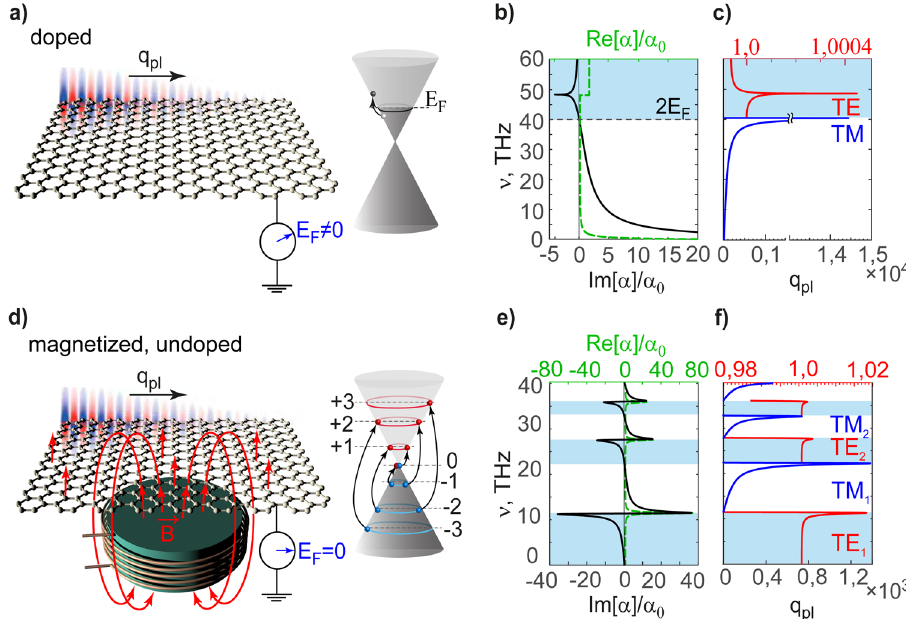
Fig. 1 Dispersion relation of GPPs in both doped non-magnetized graphene and magnetized charge neutral graphene (CNG). a Schematics for propagating graphehe plasmon-polaritons (GPP) and optical transitions between the valence band and the conduction band in the doped non-magnetized graphene. The electron fi lling is shown by the dark gray color. b Real and imaginary parts of the normalized conductivity of doped non-magnetized graphene (shown in units of the fi ne structure constant α 0 = 1/137) as a function of frequency, v . The frequency bands where Im[ α ] > 0 and Im[ α ] < 0 are highlighted by white and blue horizontal stripes, respectively. c Dispersion relations for GPPs in doped non-magnetized graphene calculated at zero temperature, T , at Fermi energy E F = 0.1 eV and relaxation time τ = 1 ps . d Schematics for propagating GPP and schematics of optical transitions between the valence band and the conduction band in magnetized CNG. The electron fi lling is shown by the dark gray color. Landau levels are shown by blue and red lines in the Dirac cones. e Real and imaginary parts of the normalized conductivity of magnetized CNG as a function of frequency, v . The frequency bands where Im[ α ] > 0 and Im[ α ] < 0 are highlighted by white and blue horizontal stripes, respectively. f Dispersion relations for GPPs in magnetized CNG calculated at T = 0 o K , τ = 1 ps and applied magnetic fi eld B = 1.3 T